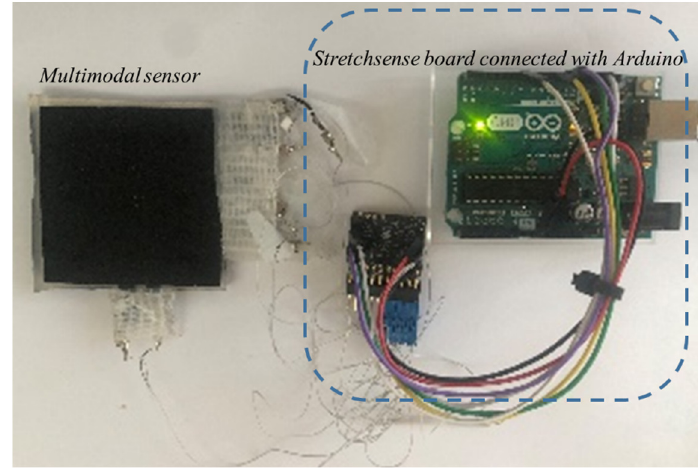
Figure 7. The electronics used to interface with the multimodal sensor.